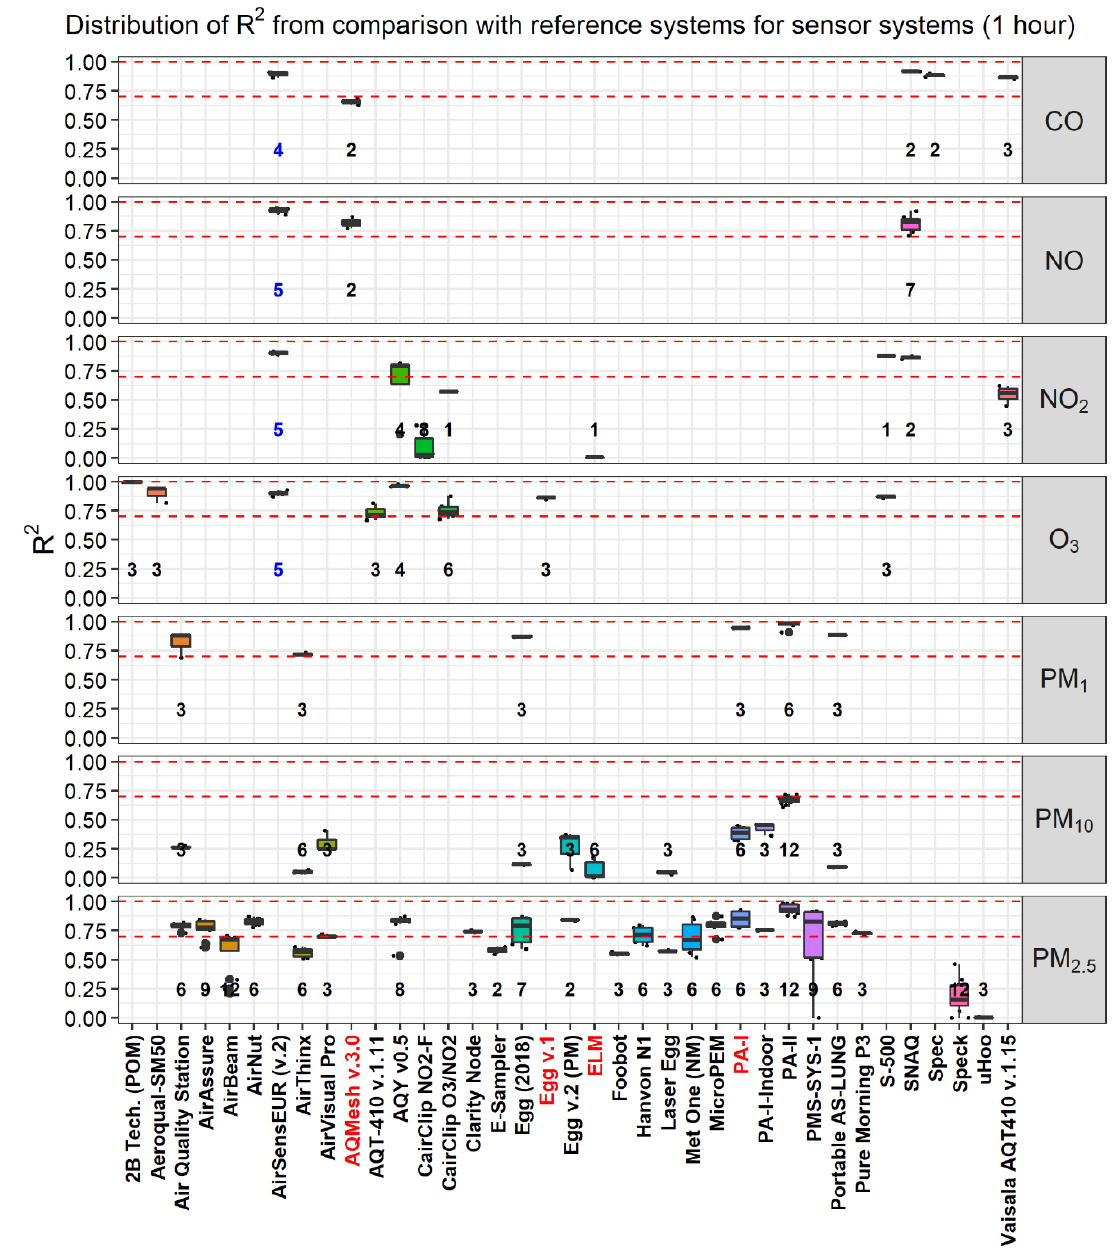
Figure A4. Distribution of R 2 from the comparison of SSys hourly data against reference measurements. Numbers in blue and black indicate the number of open source and black box records, respectively. Names of “living” and “non-living” sensors are indicated by black and red labels on the x-axis, respectively.